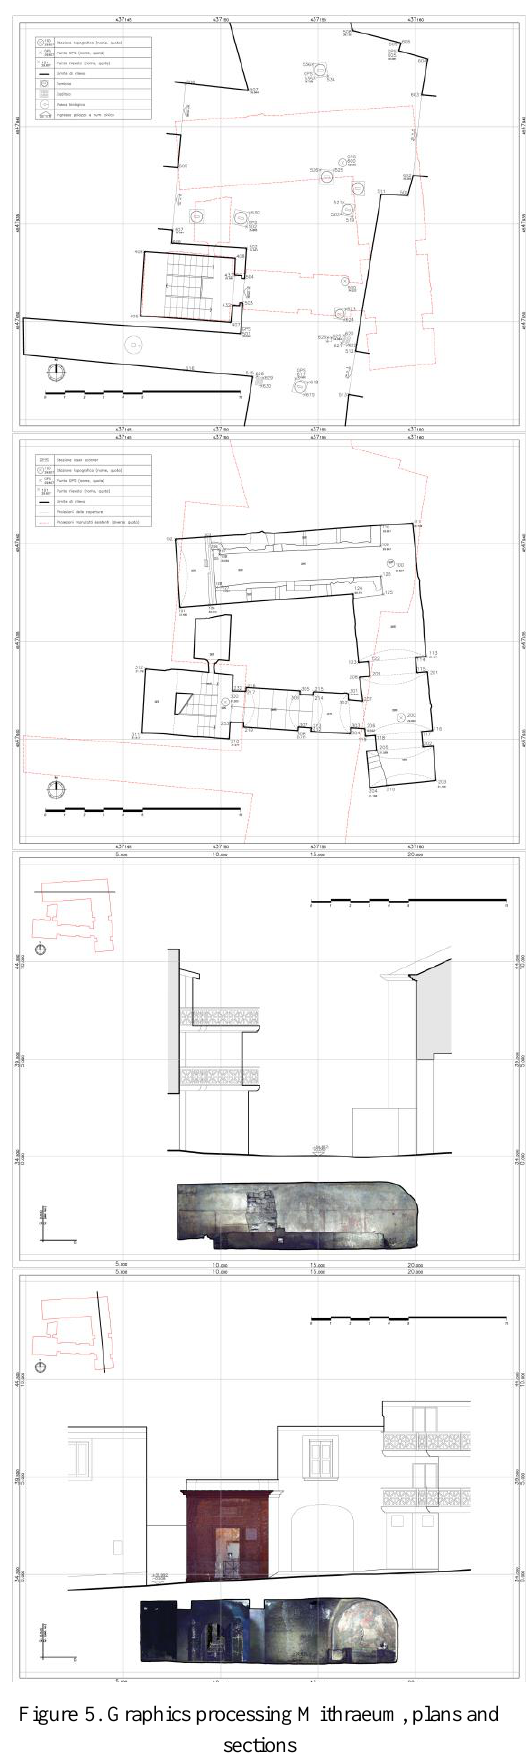
Figure 5. Graphics processing Mithraeum, plans and